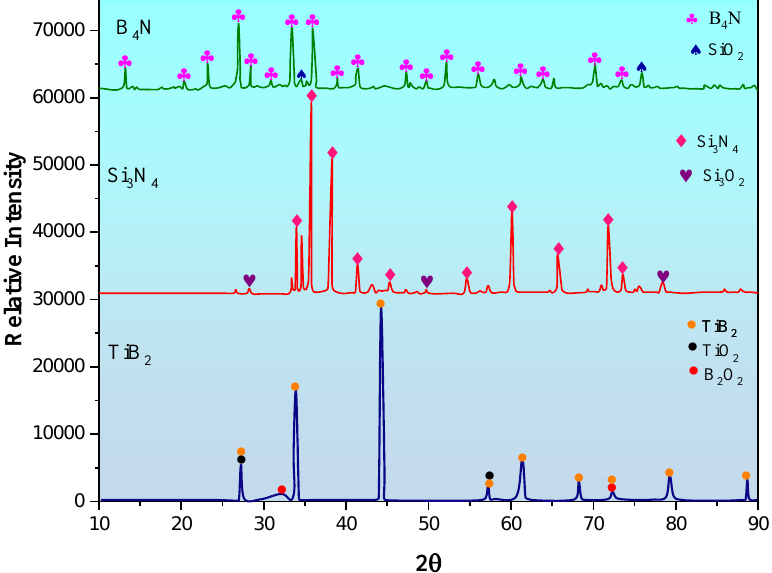
Figure 3. XRD of the as-received powder.